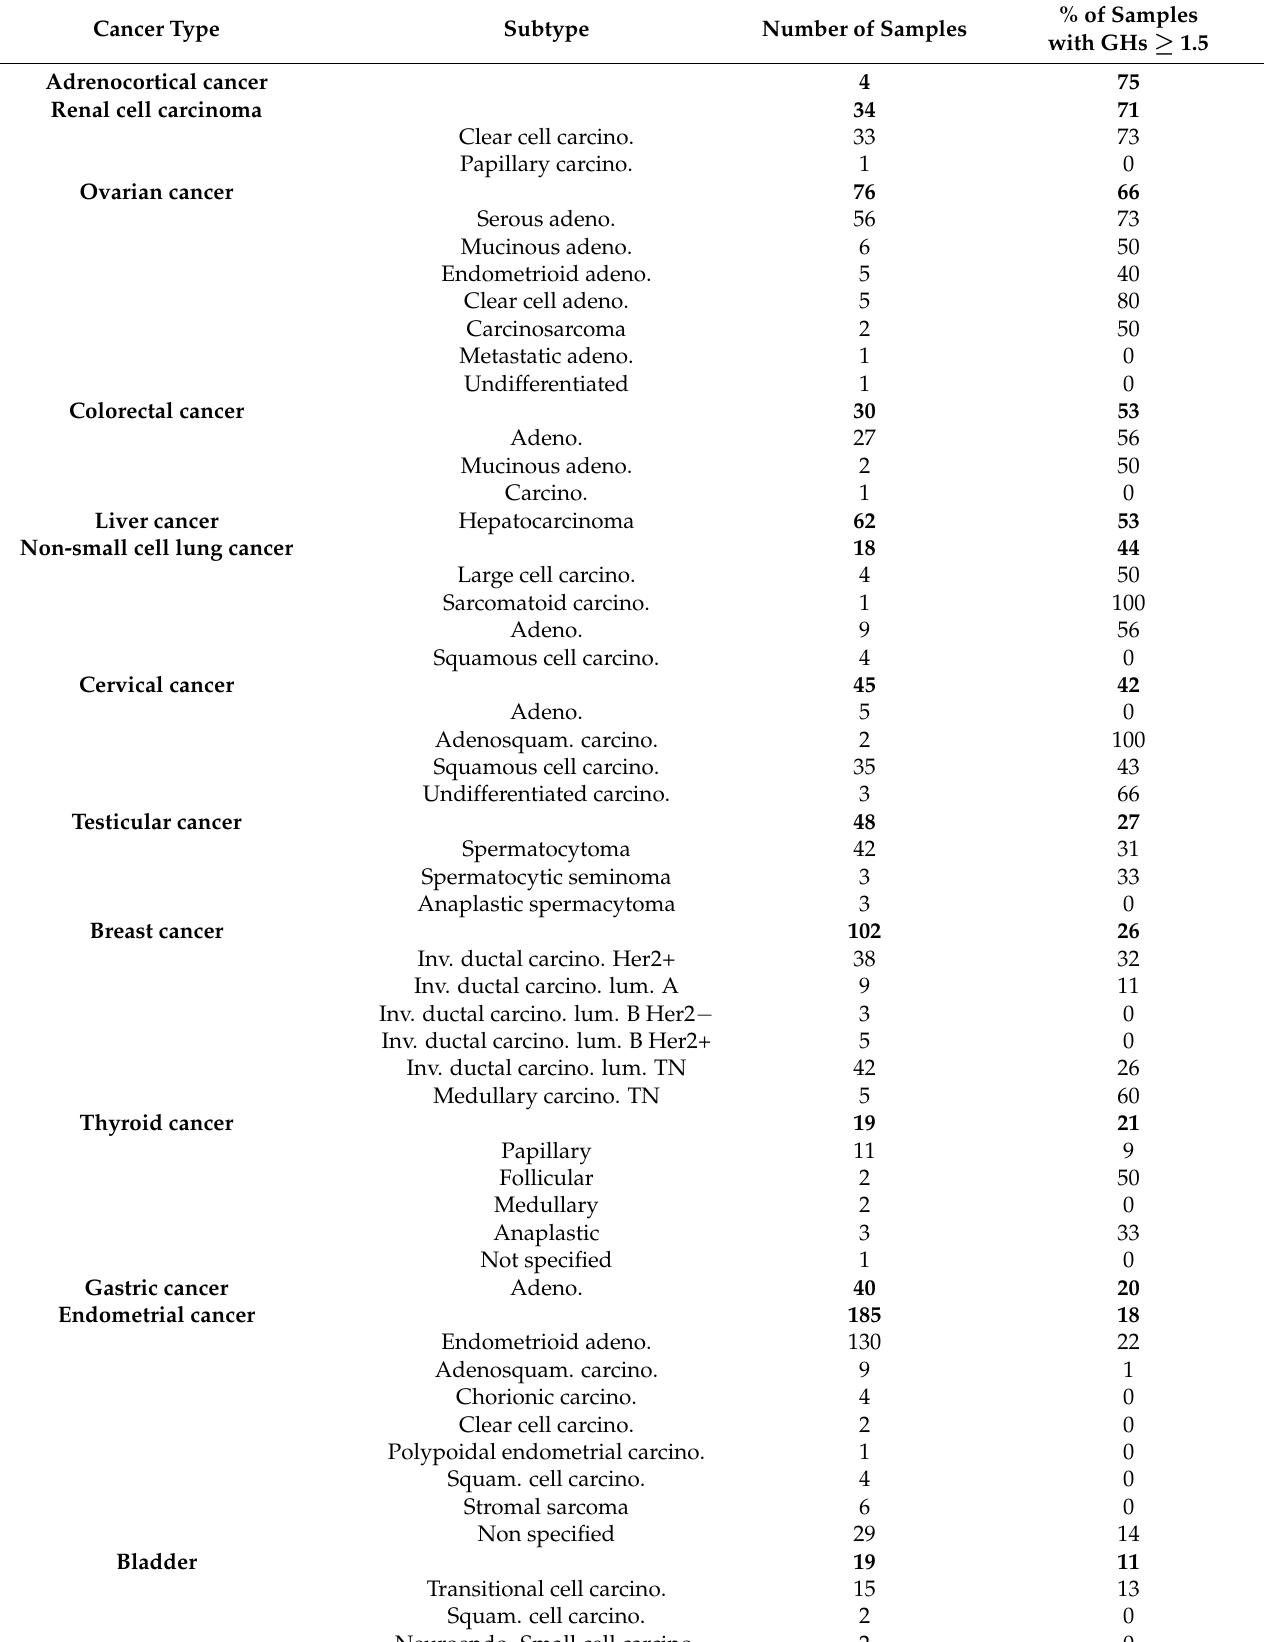
Table 1. Detection of AMHRII expression by